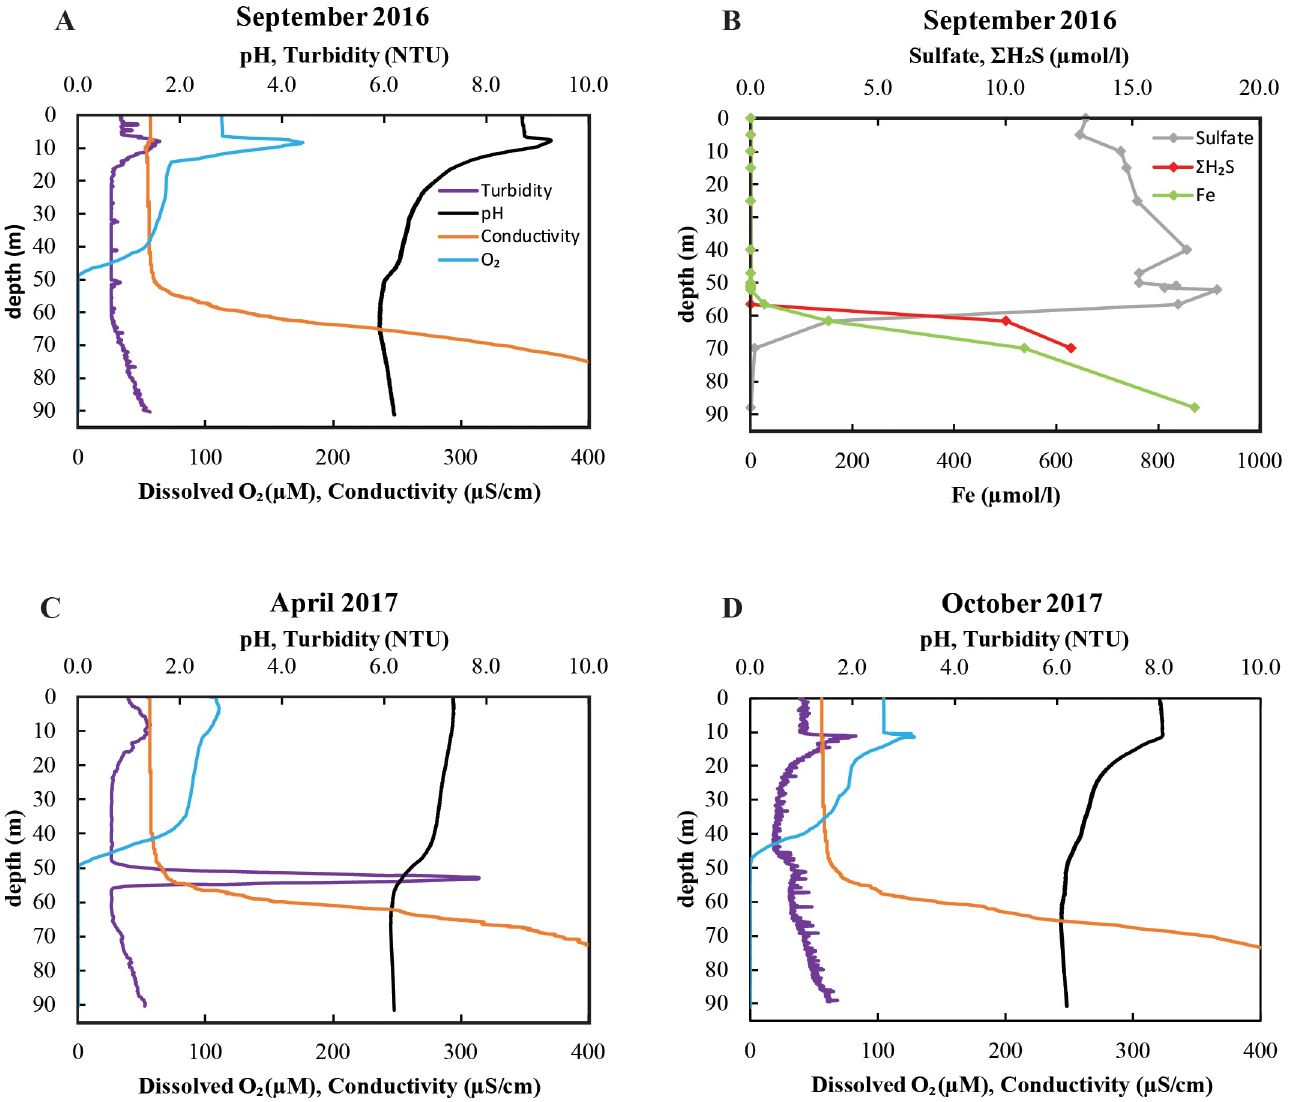
Fig 1. Geochemical profiles of the Lake Pavin water column. Profiles were measured in September 2016 (A&B), April 2017 (C), and October 2017 (D).